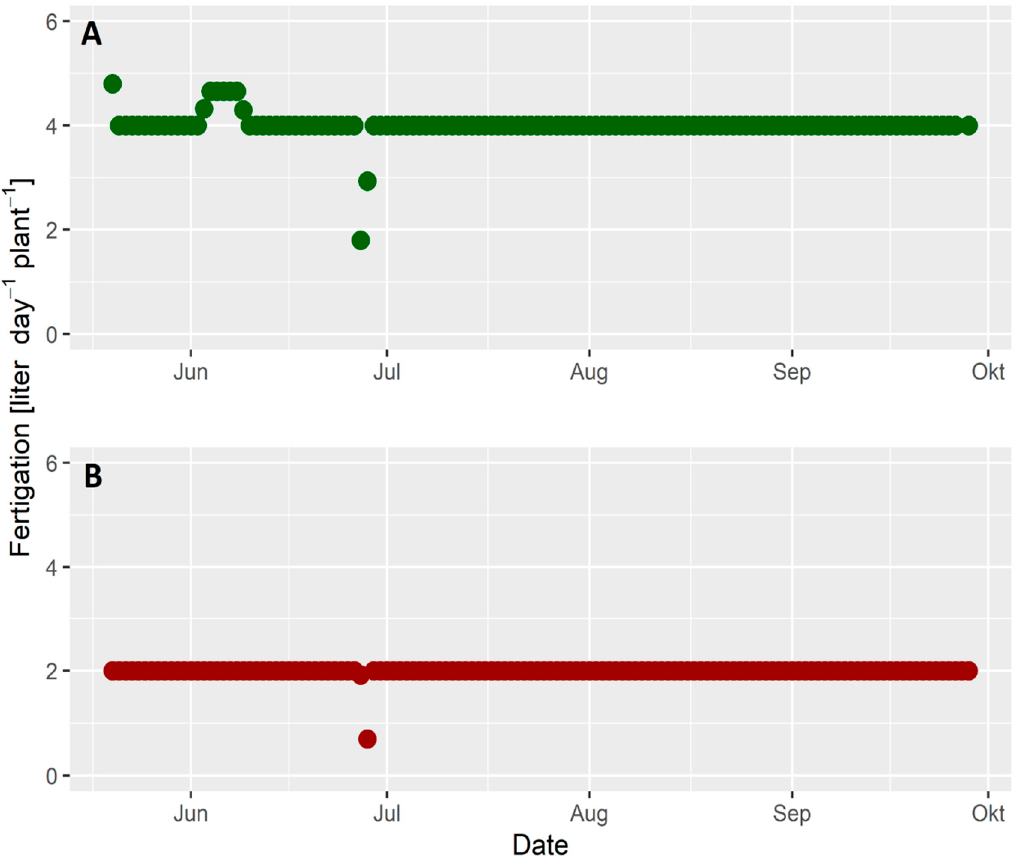
Figure 1. Daily amounts of fertigation for control ( A ) and drought stress ( B ). Occasional deviations from the desired 50% difference in fertigation between treatments occurred due to maintenance work.